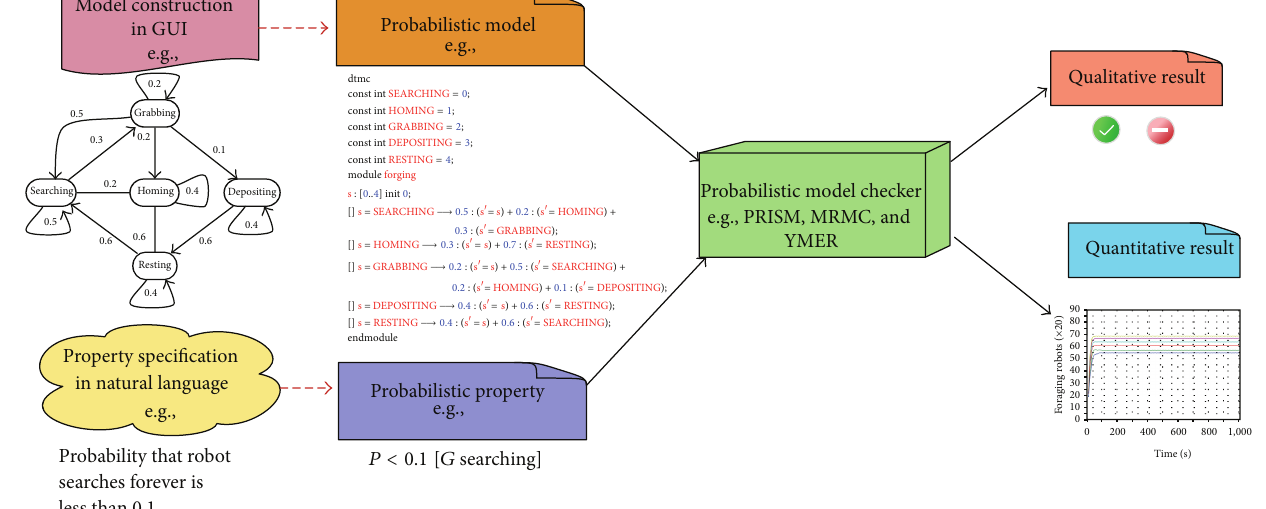
Figure 2: A light-weight approach for probabilistic model checking.